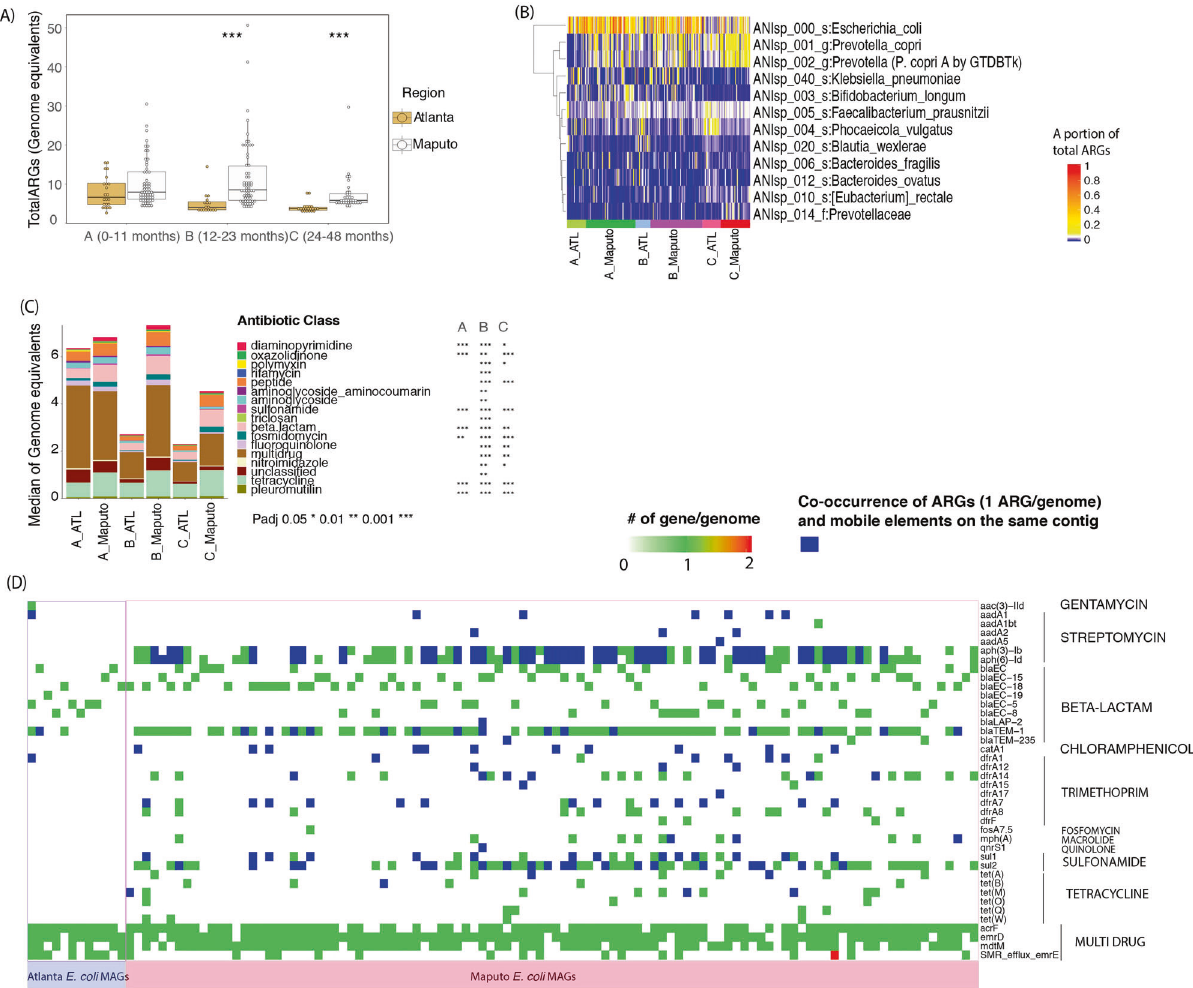
Fig. 4 Antibiotic resistance gene (ARG) abundance and prevalence in children microbiomes. A total ARG abundance in Atlanta vs. Maputo datasets ( fi gure key). B MAGs carrying most of the ARGs. Each raw represents a different genomospecies (taxonomic identity is provided on the right) and shows what fraction ( fi gure key) of total ARGs in each sample (columns) is carried by the genomospecies. C Relative abundances (measured as Genome Equivalents or GEs; y -axis) of antibiotic resistance classes in each age group ( x -axis) that showed signi fi cant differences in at least one age group comparison between the two locations. P adj 0.05* 0.01** 0.001***, based on Dunn ’ s test. Sample names are as in Fig. 1. D Prevalence of ARGs in E. coli MAGs and their co-occurrence with mobile elements (integrons and transposons). For the complete description of each ARG protein shown, see Table